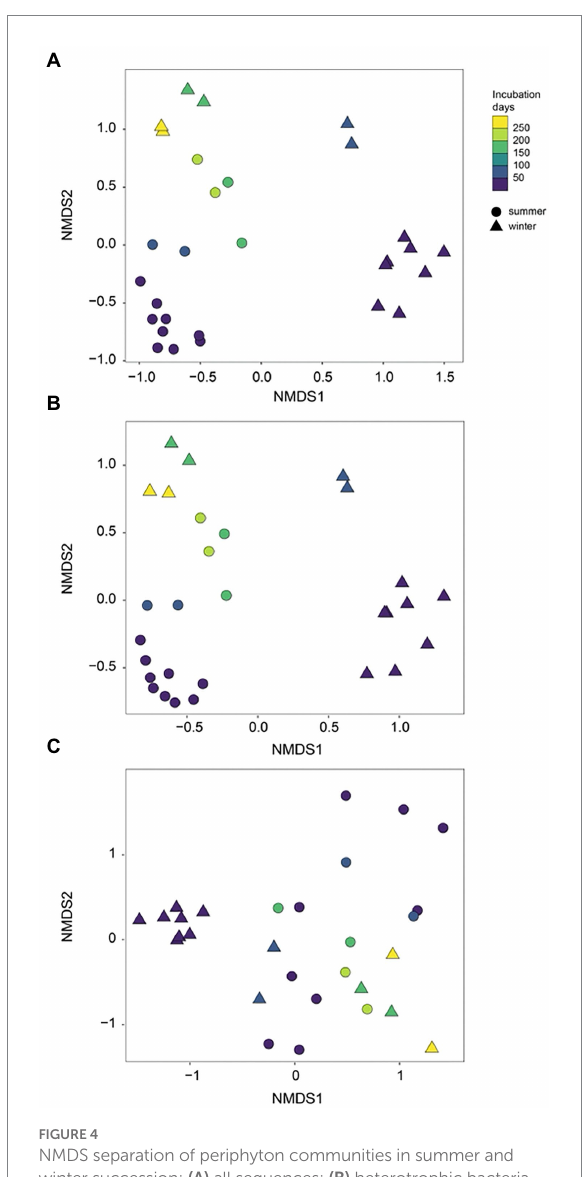
FIGURE 4 NMDS separation of periphyton communities in summer and winter succession: (A) all sequences; (B) heterotrophic bacteria only; (C) algae (chloroplast) + cyanobacteria only. Summer and winter succession are in different symbols and color gradients indicate the incubation time